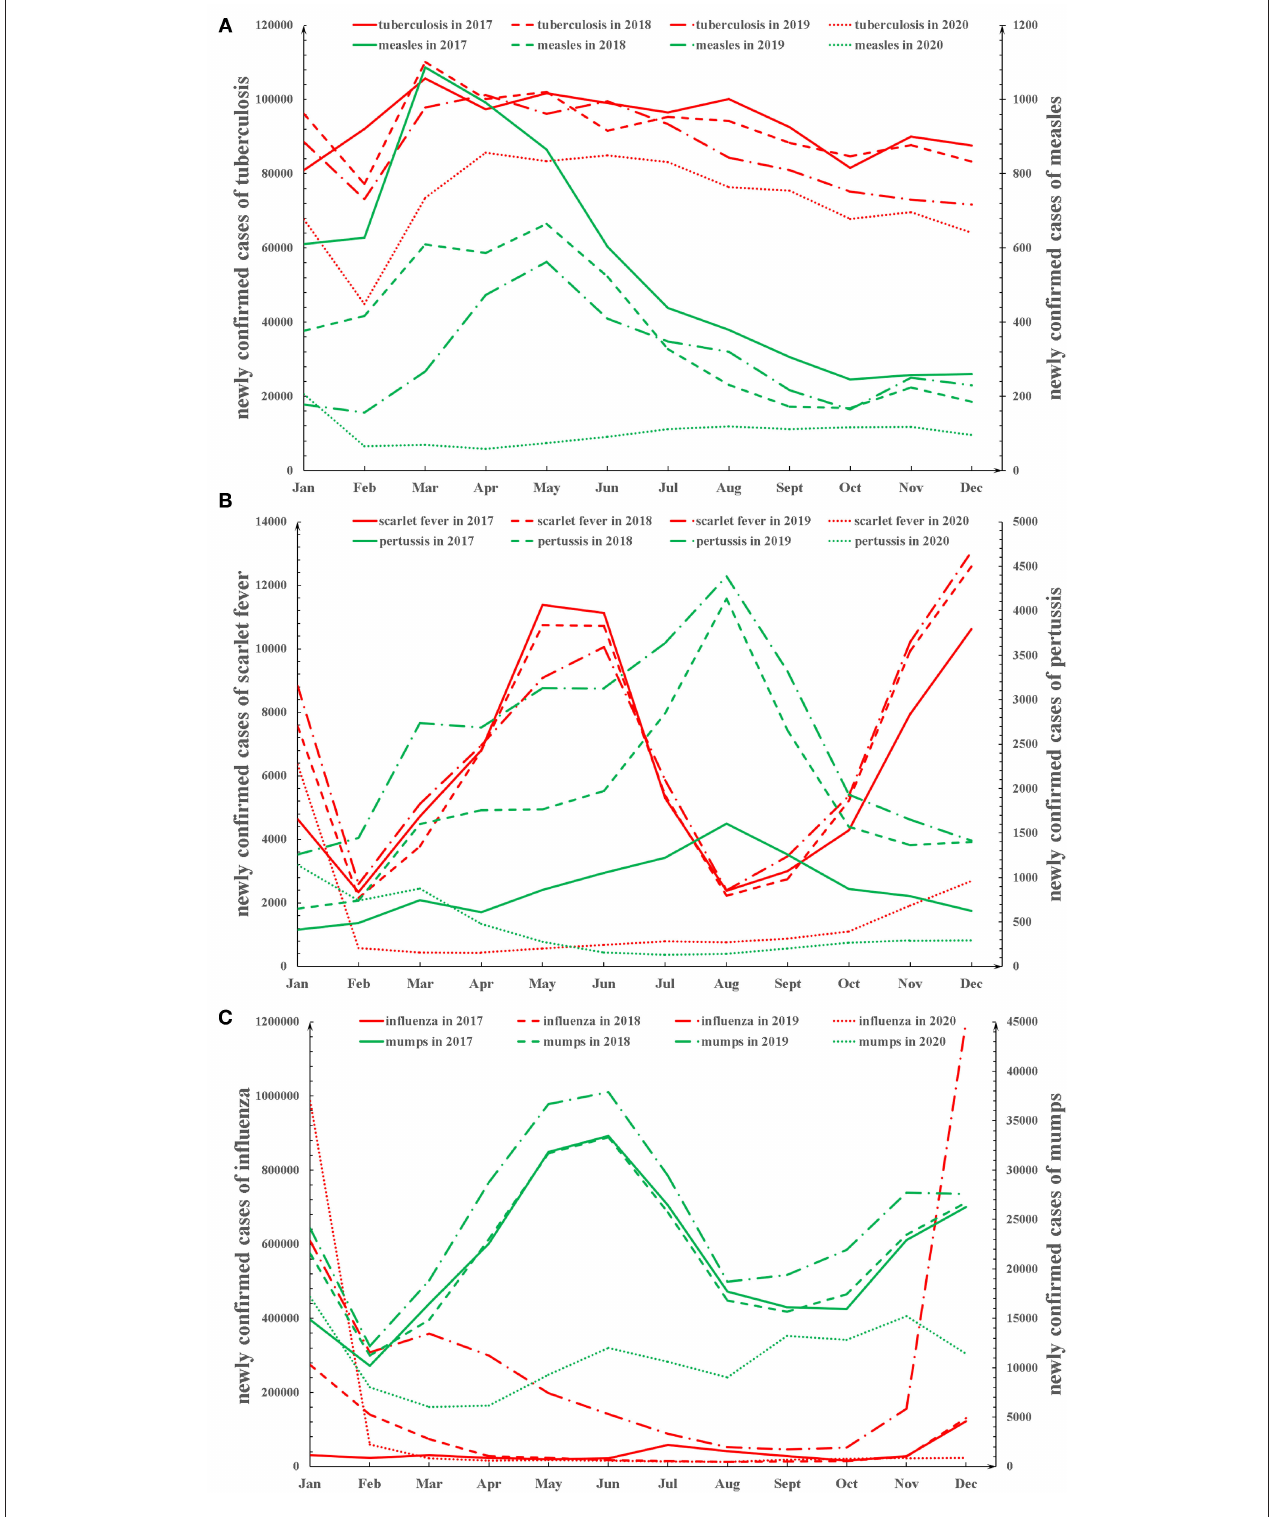
FIGURE 1 | The trends of the monthly newly confirmed cases of the six respiratory infectious diseases from 2017 to 2020 in China. (A) The trends of the monthly newly confirmed cases of measles and tuberculosis from 2017 to 2020. (B) The trends of the monthly newly confirmed cases of pertussis and scarlet fever from 2017 to 2020. (C) The trends of the monthly newly confirmed cases of influenza and mumps from 2017 to 2020.